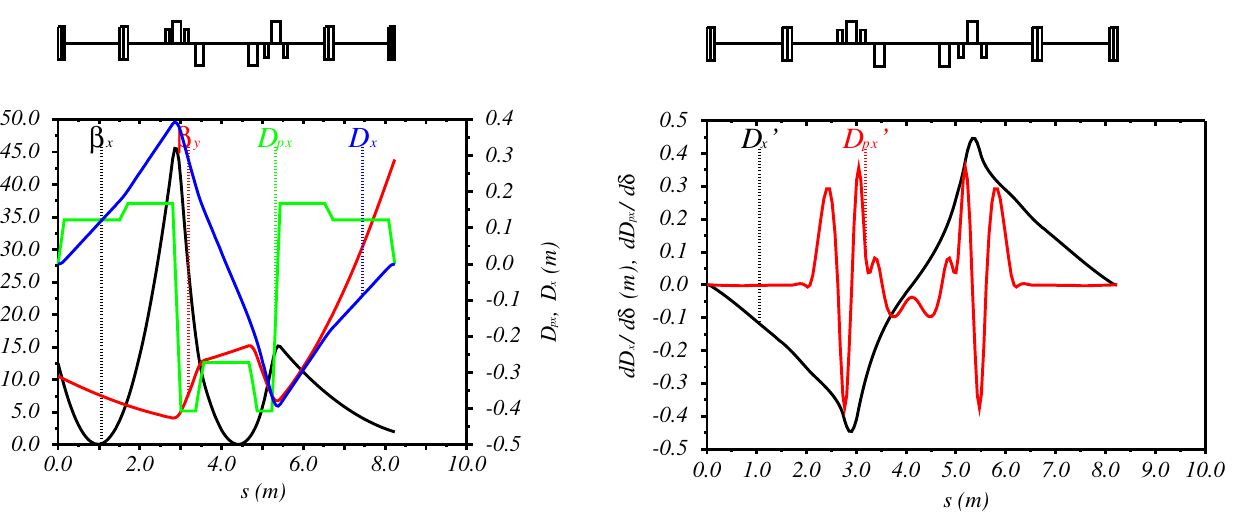
FIG. 3. Second order optics of bunch compressor one. Black curve denotes second order horizontal dispersion function and red curve second order horizontal angular dispersion